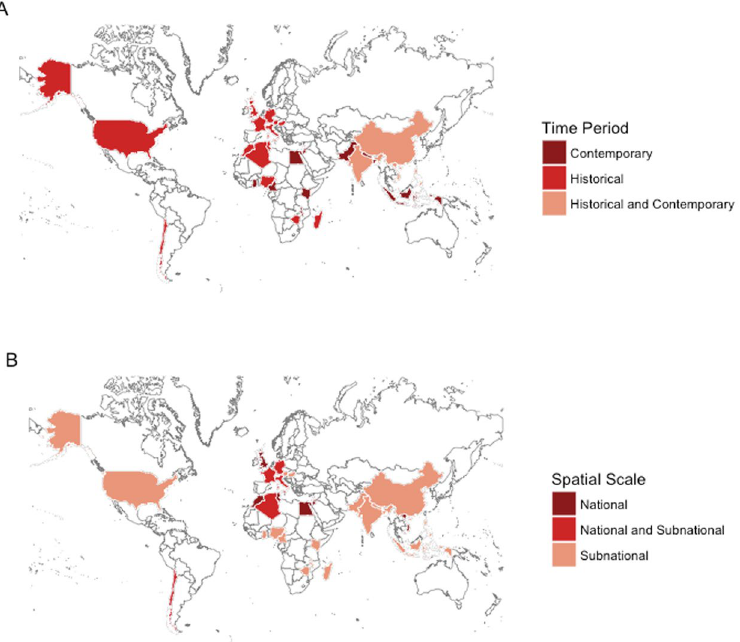
Figure 1. Map of countries for which data was available by ( A ) time period and ( B ) spatial resolution of the data. The Map was created in R 3.2.4 (R Foundation for Statistical Computing, Vienna, Austria) using the ggplot2 45 and maptools 46